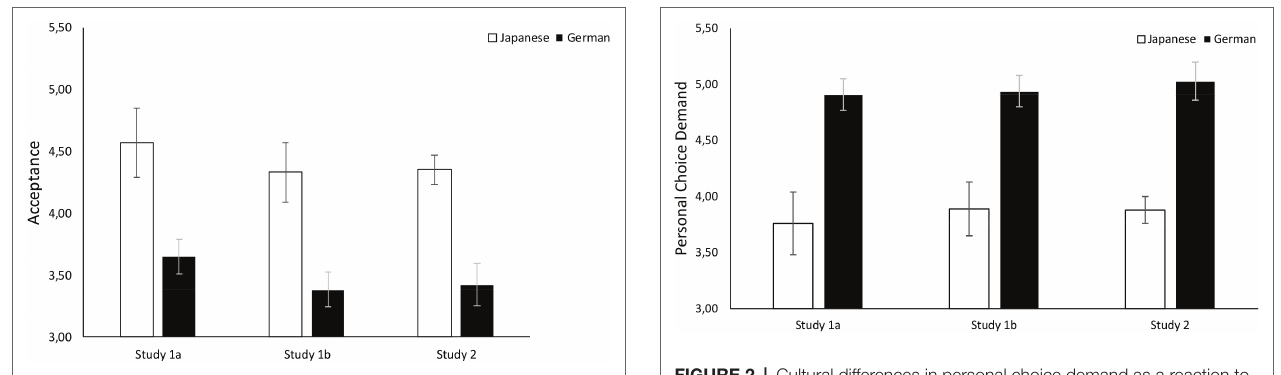
FIGURE 1 | Cultural differences in acceptance of vicarious choice in Studies 1a, 1b, and 2. Error bars show 95% confidence intervals.